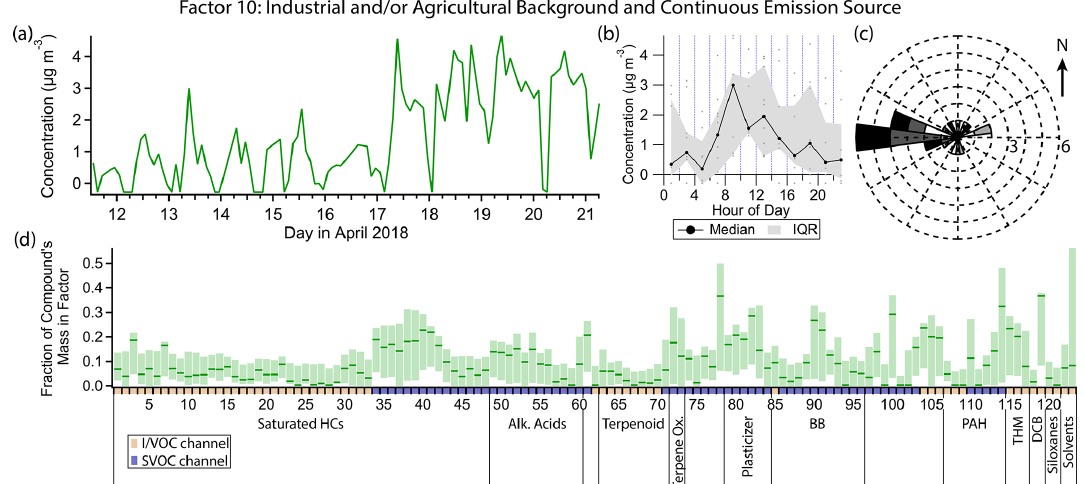
Figure 15. (a) Factor 10 timeline. (b) Diurnal profile for Factor 10. (c) Rose plot showing correlation of elevated emissions and wind direction. (d) Factor 10 composition profile. See Fig. 4 description for further information on how to read this